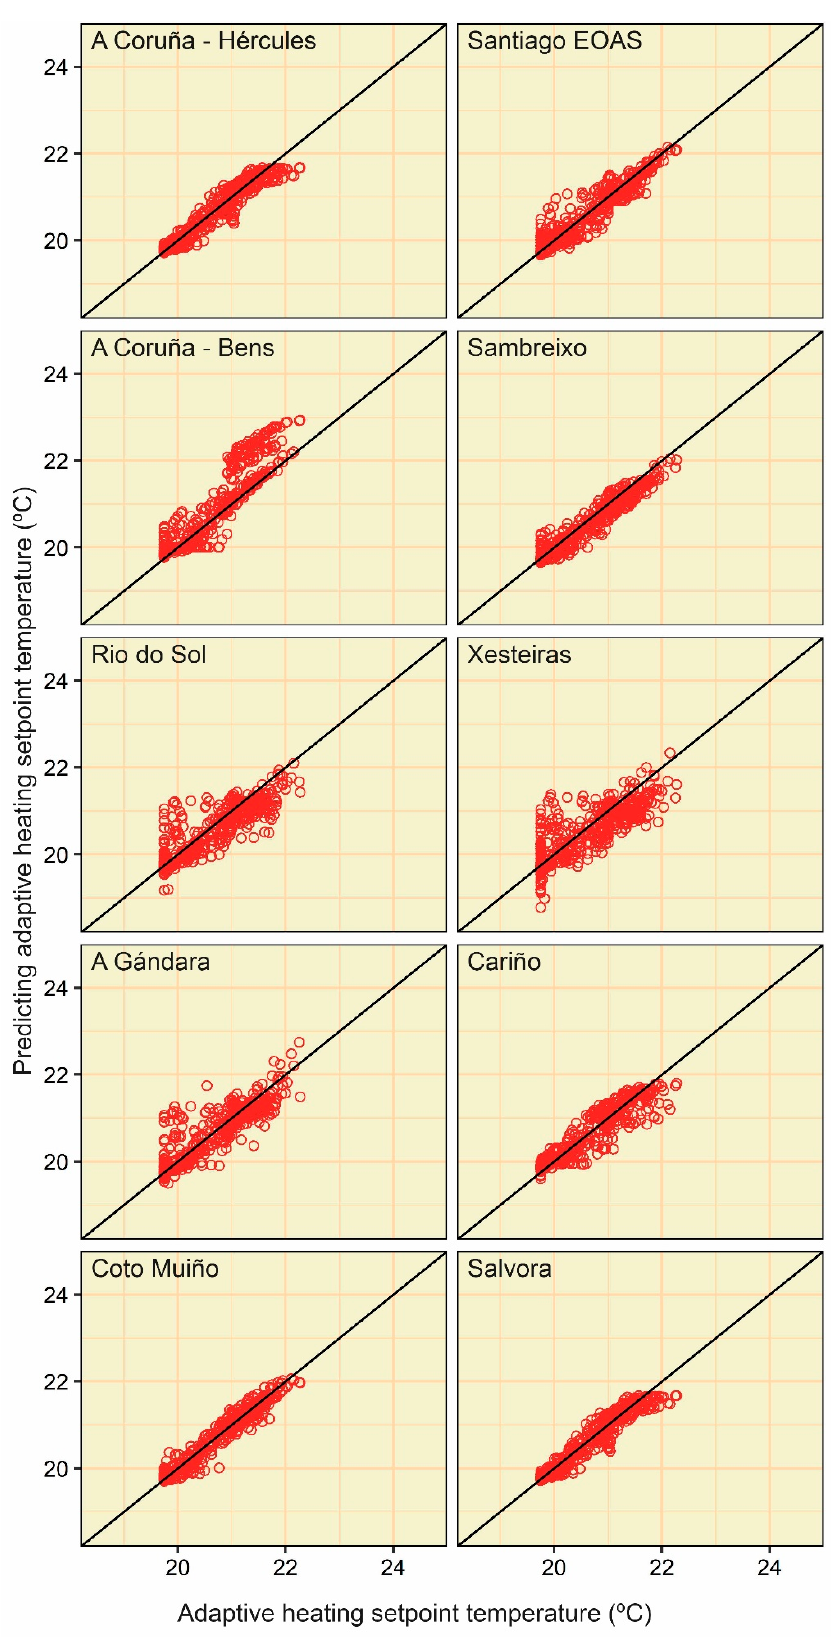
Figure A24. Point clouds between the actual and predicting adaptive heating setpoint temperature values (category III) of the MLP (approach 2).